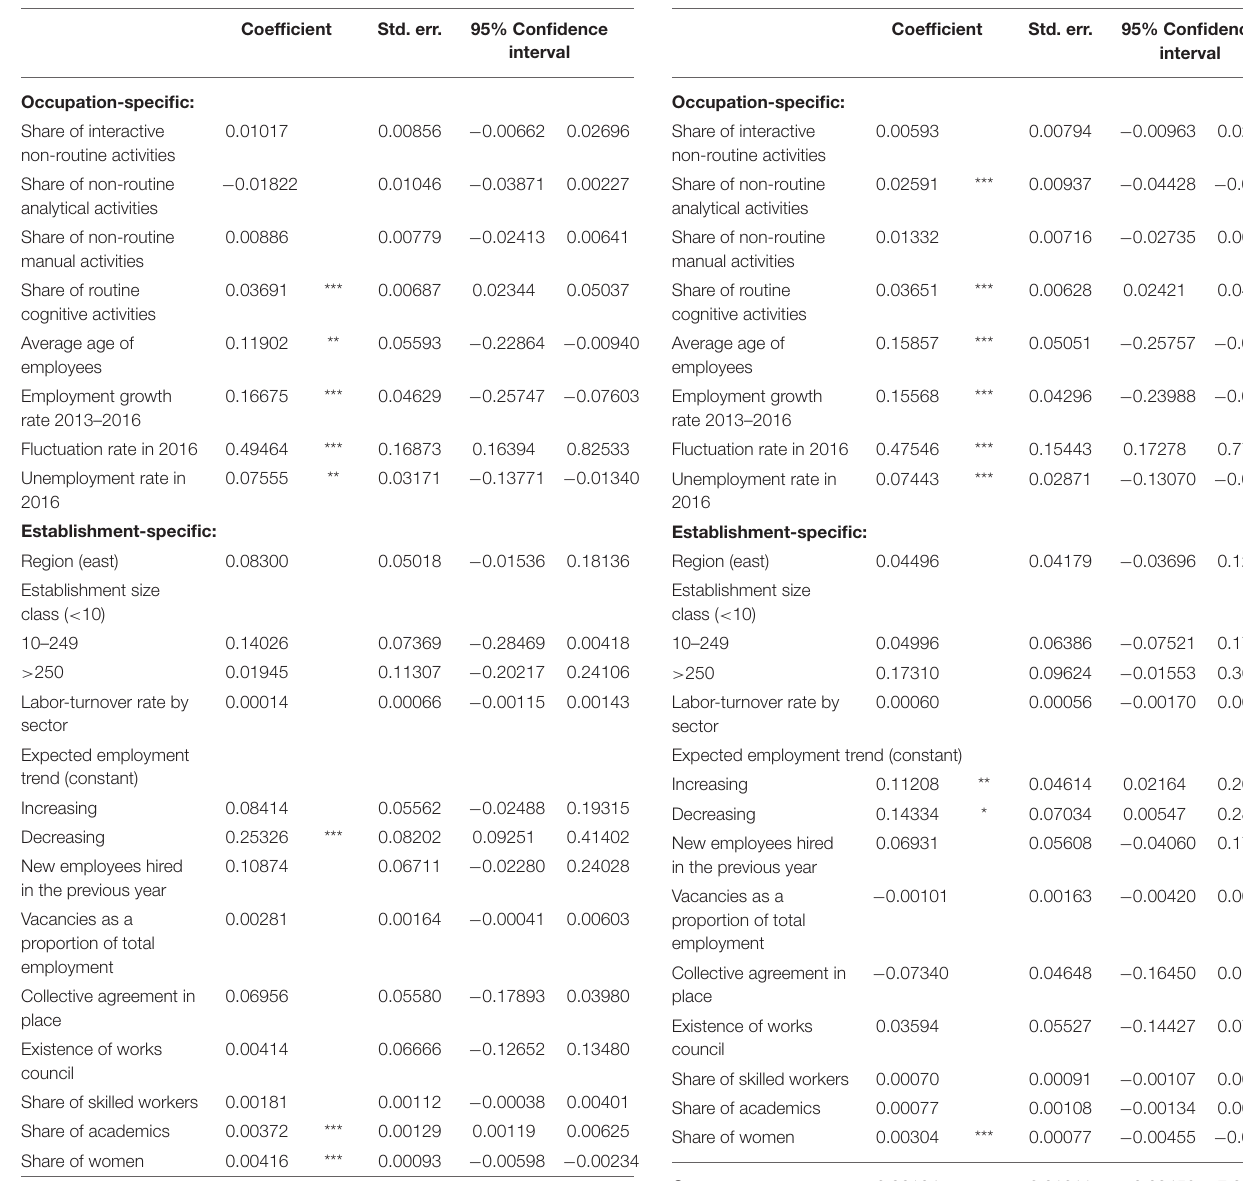
TABLE 5 | Estimation results: increasing requirements regarding workplace flexibility.